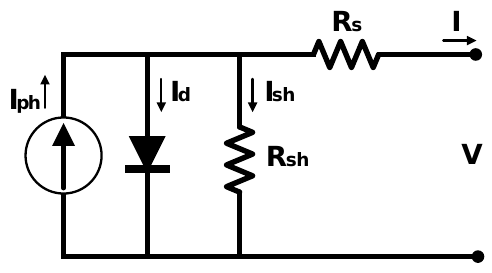
Figure 1. Equivalent circuit model of a photovoltaic (PV)